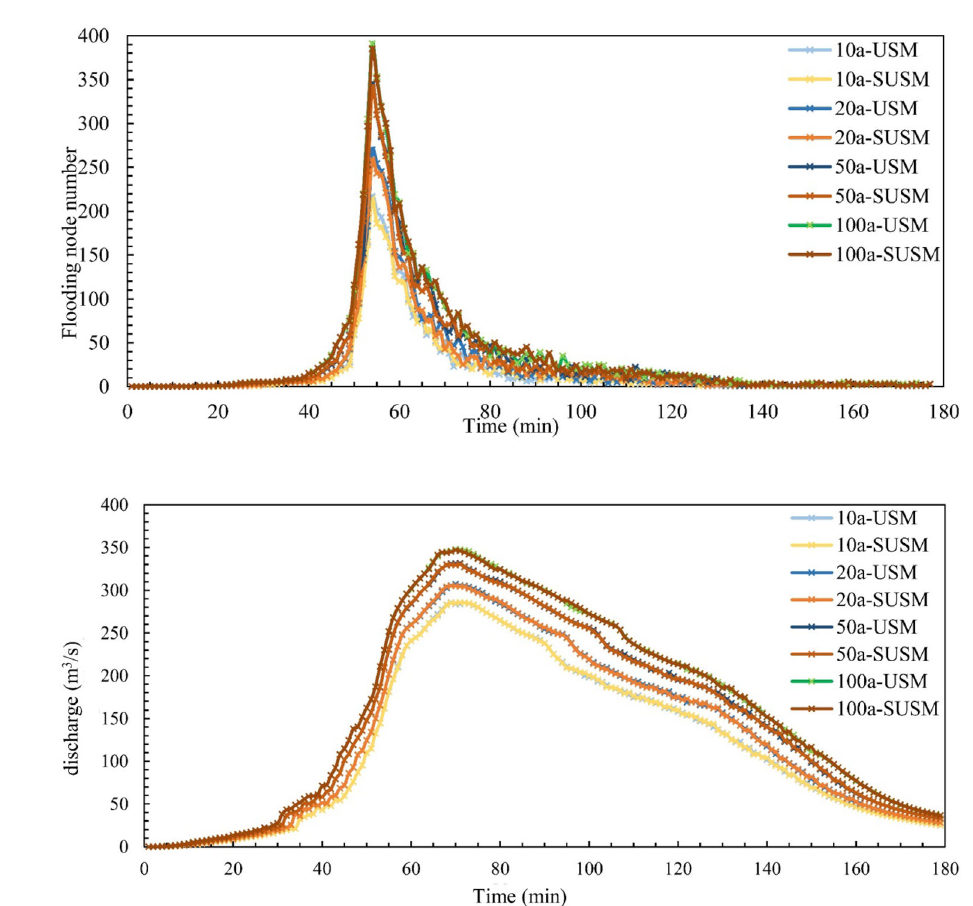
Fig. 10 Hydrographs of the outlet of the urban stormwater model (USM) and simplified urban stormwater model (SUSM) in the four rainfall return periods (10a, 20a, 50a, and